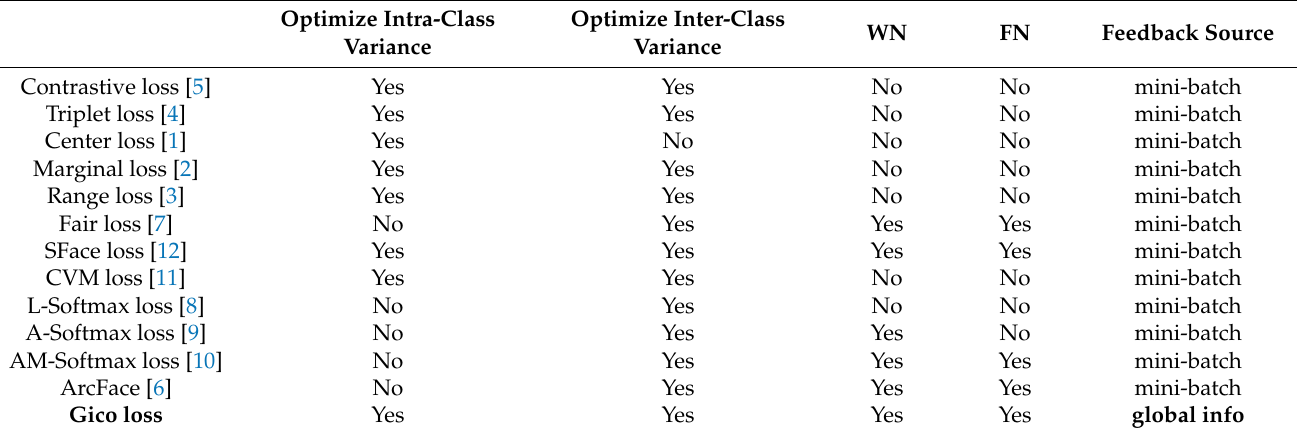
Table 1. The properties of different losses in deep face recognition.